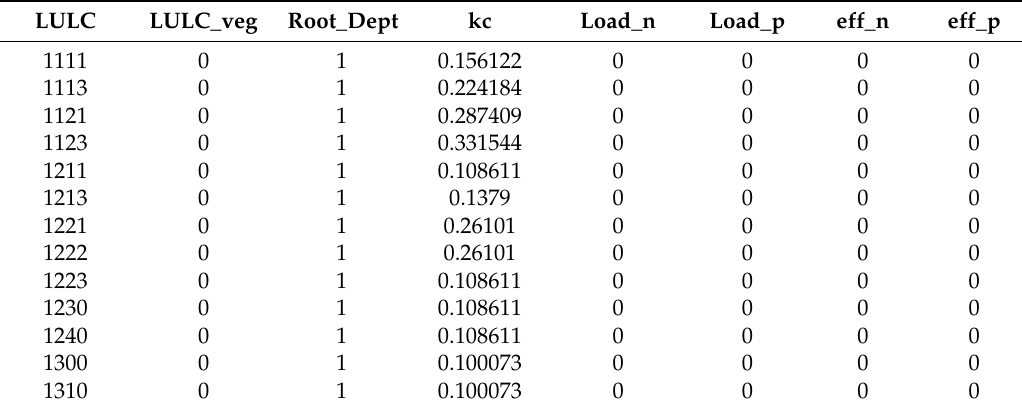
Table A1. Table of input data associated to LULC